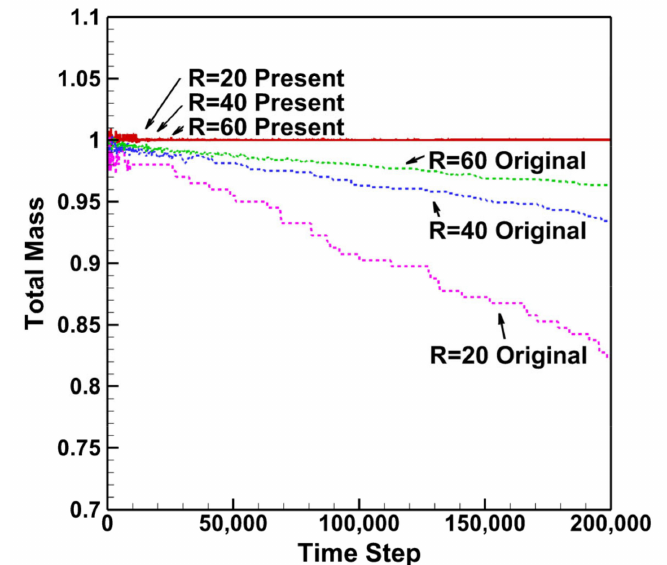
Figure 8. Variation in the mass for the whole bubble at σ =